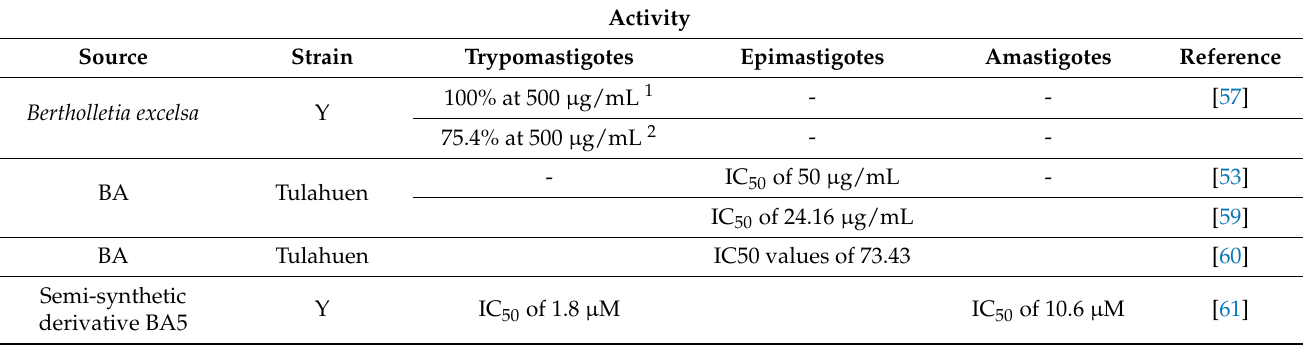
Table 2. Summarized activity of betulinic acid against T. cruzi